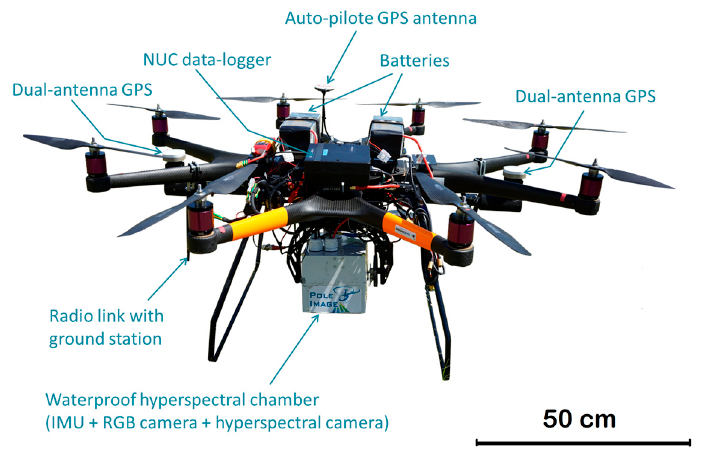
Figure 1. Hyper-DRELIO (Hyperspectral DRone for Environmental and LIttoral Observations) platform, Unmanned Aerial Vehicle (UAV) for hyperspectral imagery. NUC: Next Unit of Computing; IMU: Inertial Motion Unit; GPS: Global Positioning System.